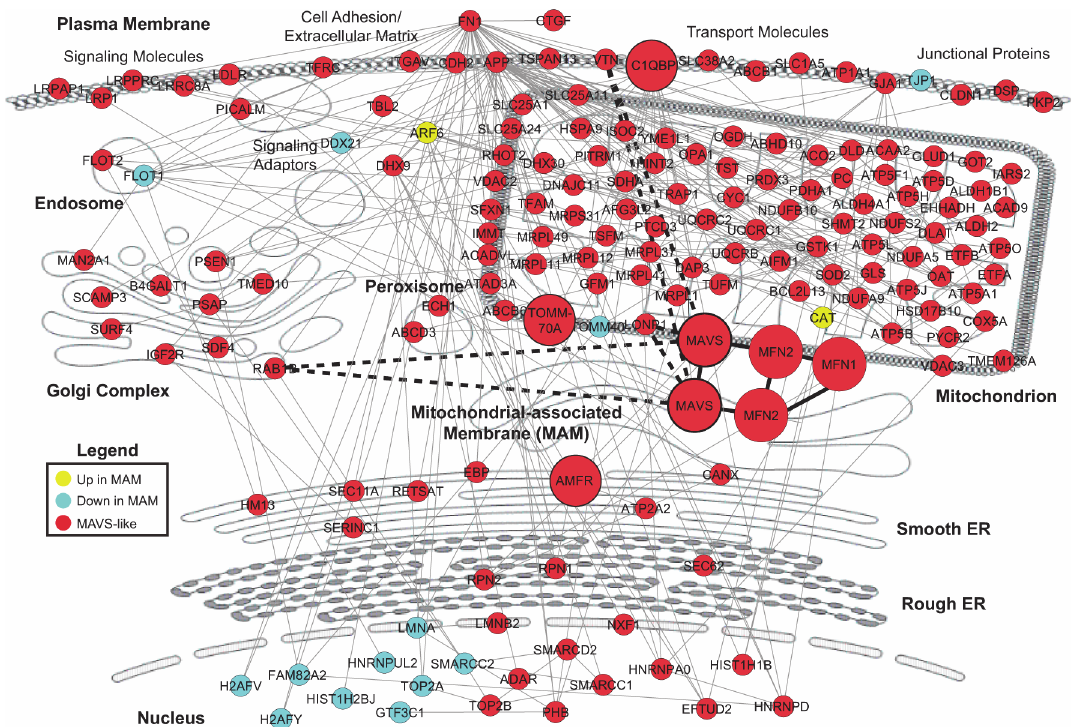
Fig 5. Cellular interaction network of proteins identified with dynamic MAM localization during RNA virus replication. Cellular mapping of the interaction network of proteins identified in MAM fractions that either increase in the MAM with HCV and SenV (yellow), decrease in the MAM with both HCV and SenV (blue), or that have “ MAVS-like ” localization (red; decreased in the MAM with HCV, increased or unchanged in MAM with SenV). The interaction network was determined by using InnateDb and visualized with Cytoscape. It includes all proteins that interact with at least one other protein. Bold-faced dotted edges represent protein-protein interactions discovered and validated in this study. Previously described MAVS-interacting proteins (MAVS, MFN1, MFN2, C1QBP, AMFR, and TOMM70) are highlighted by large red circles. Nodes representing each protein were positioned on a cell map according to subcellular localization using annotation information from